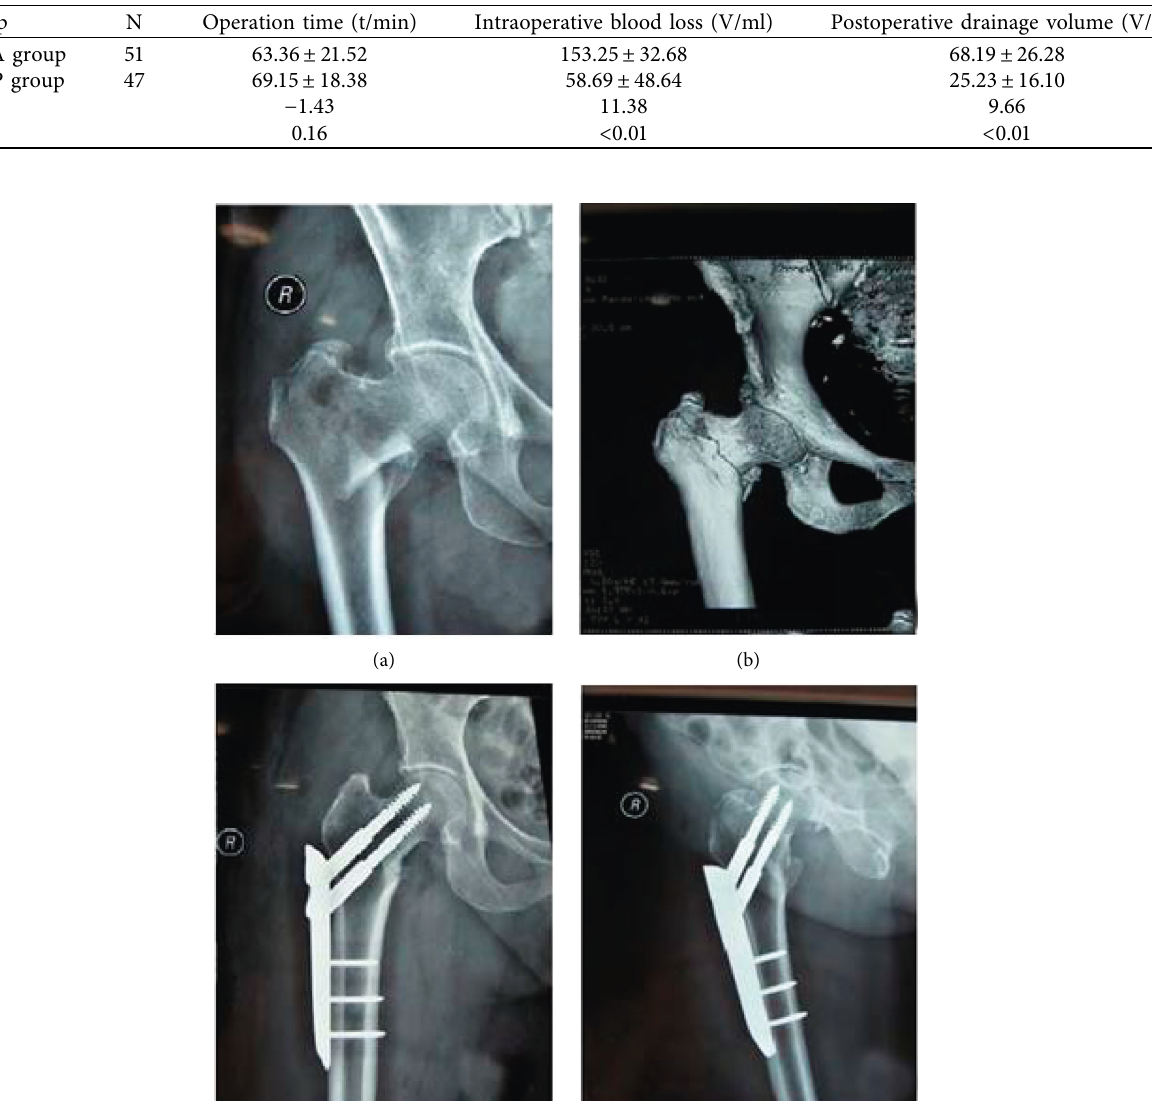
Table 2: Comparison of intraoperative indicators between the two groups ( x ± s , n � 98).